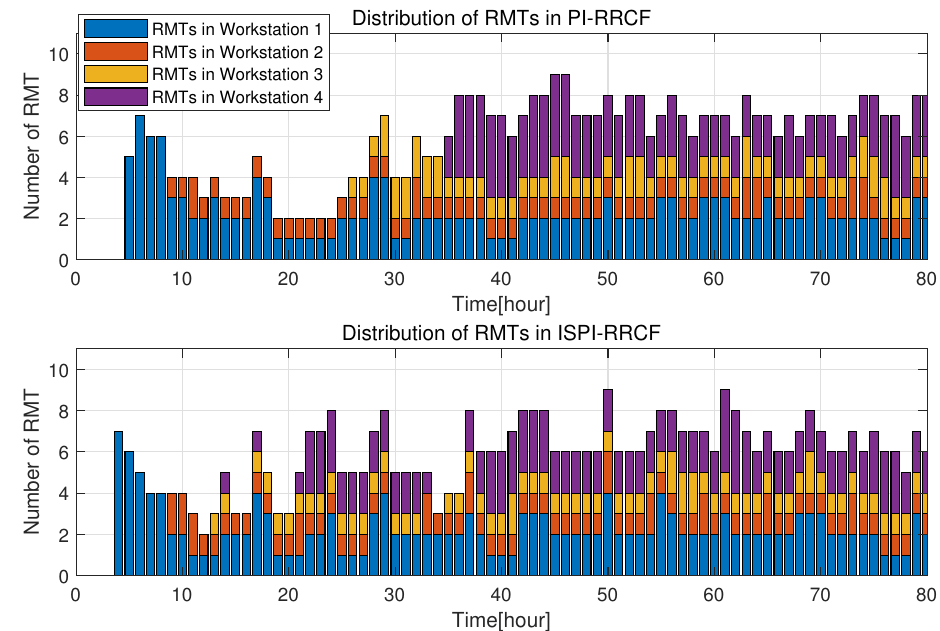
Figure 8. Distribution of RMTs for stochastic